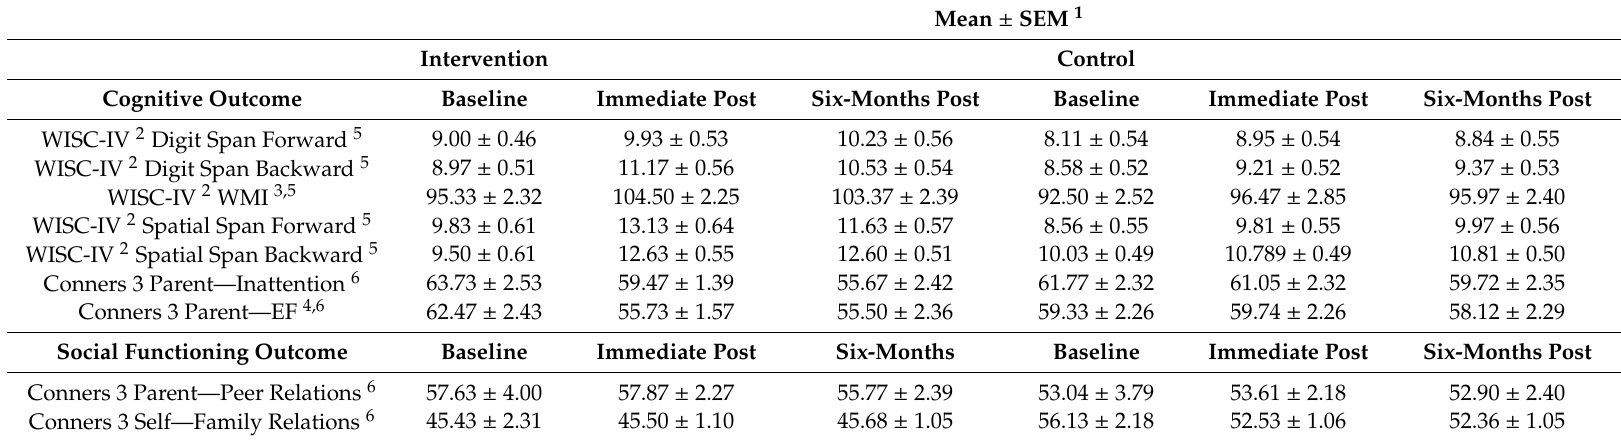
Table 2. Cognitive and social functioning scores at baseline, immediate post-intervention, and six-months